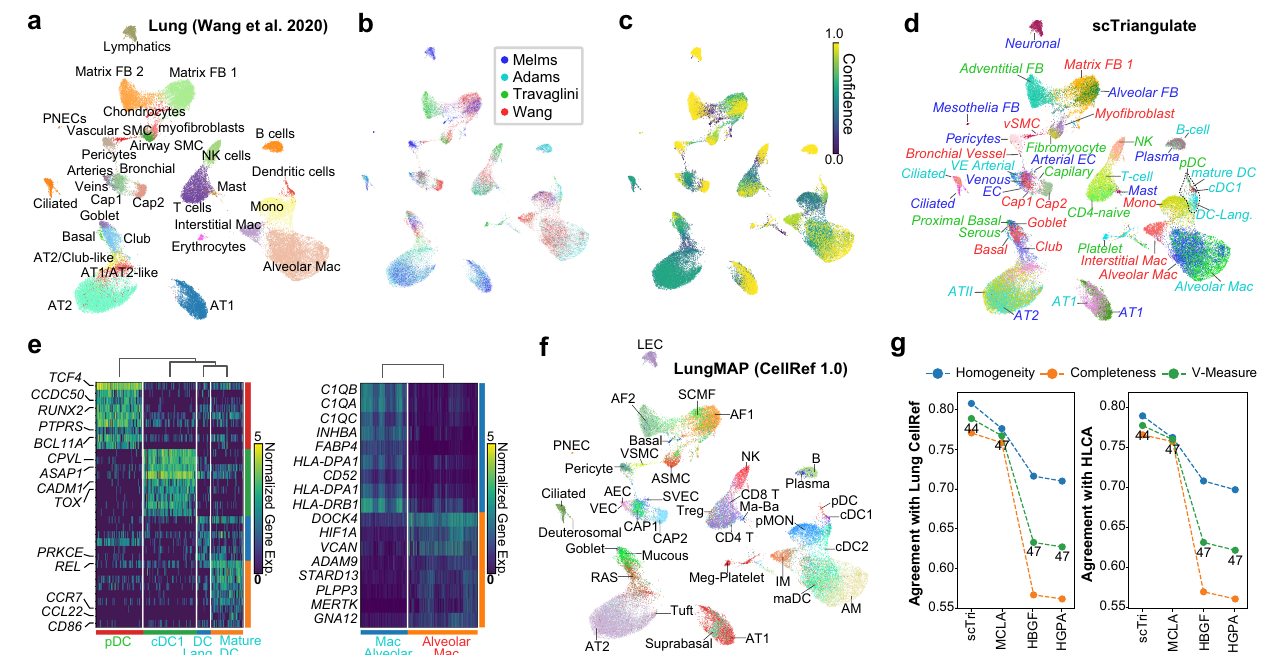
Fig. 5 | Automated integration of cell-atlases. scTriangulate of four competing lung cell atlases projected onto snRNA-Seq from nine donors (Wang et al. 2020) 24 . a Wang et al. source annotations and scRNA-Seq. b scTriangulate winning clusters after integrating labels from three other lung atlas studies projected onto Wang (Melms 25 ,Adams 26 ,Travaglini 27 )(Methods). c Thecon fi denceofeachscTriangulate- de fi ned cluster based on the “ winning-fraction ” of cells in each cluster (Methods). d scTriangulate fi nal label assignments, corresponding to panel ( b ). e Heatmap displaying the top discriminating dendritic (left) and macrophage (right) cell